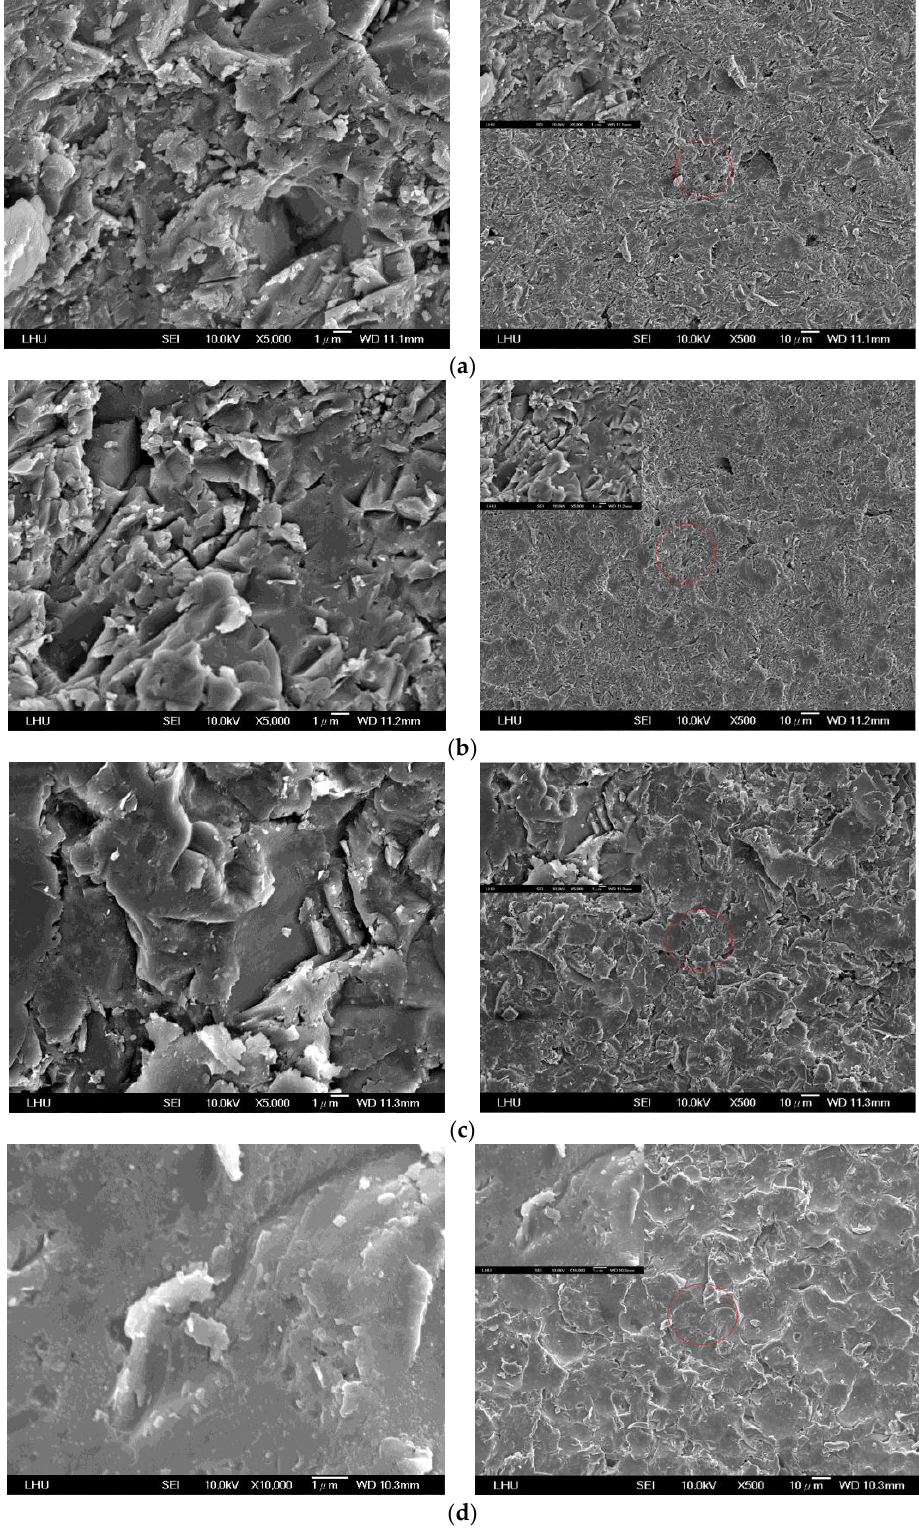
Figure 2. SEM images of Al template by powder blasting processing: ( a ) MS 245A (Φ = 50–250 μm); ( b ) MS 300A (Φ = 30–70 μm); ( c ) MS 550A (Φ = 10–20 μm); ( d ) MS 550BT (Φ = 20–30 μm).